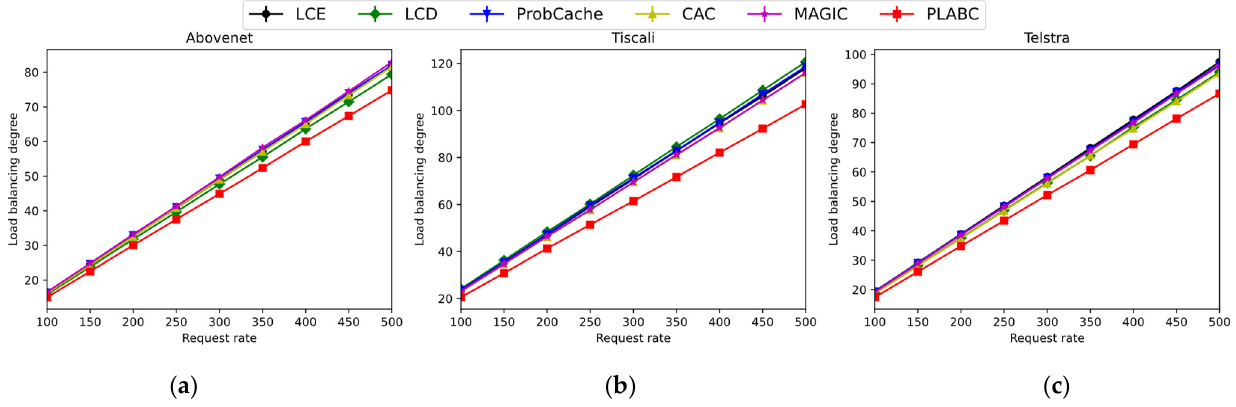
Figure 18. Load balancing degree results from different caching strategies when the total request rate varies under topology: ( a ) Abovenet; ( b ) Tiscali; ( c ) Telstra.